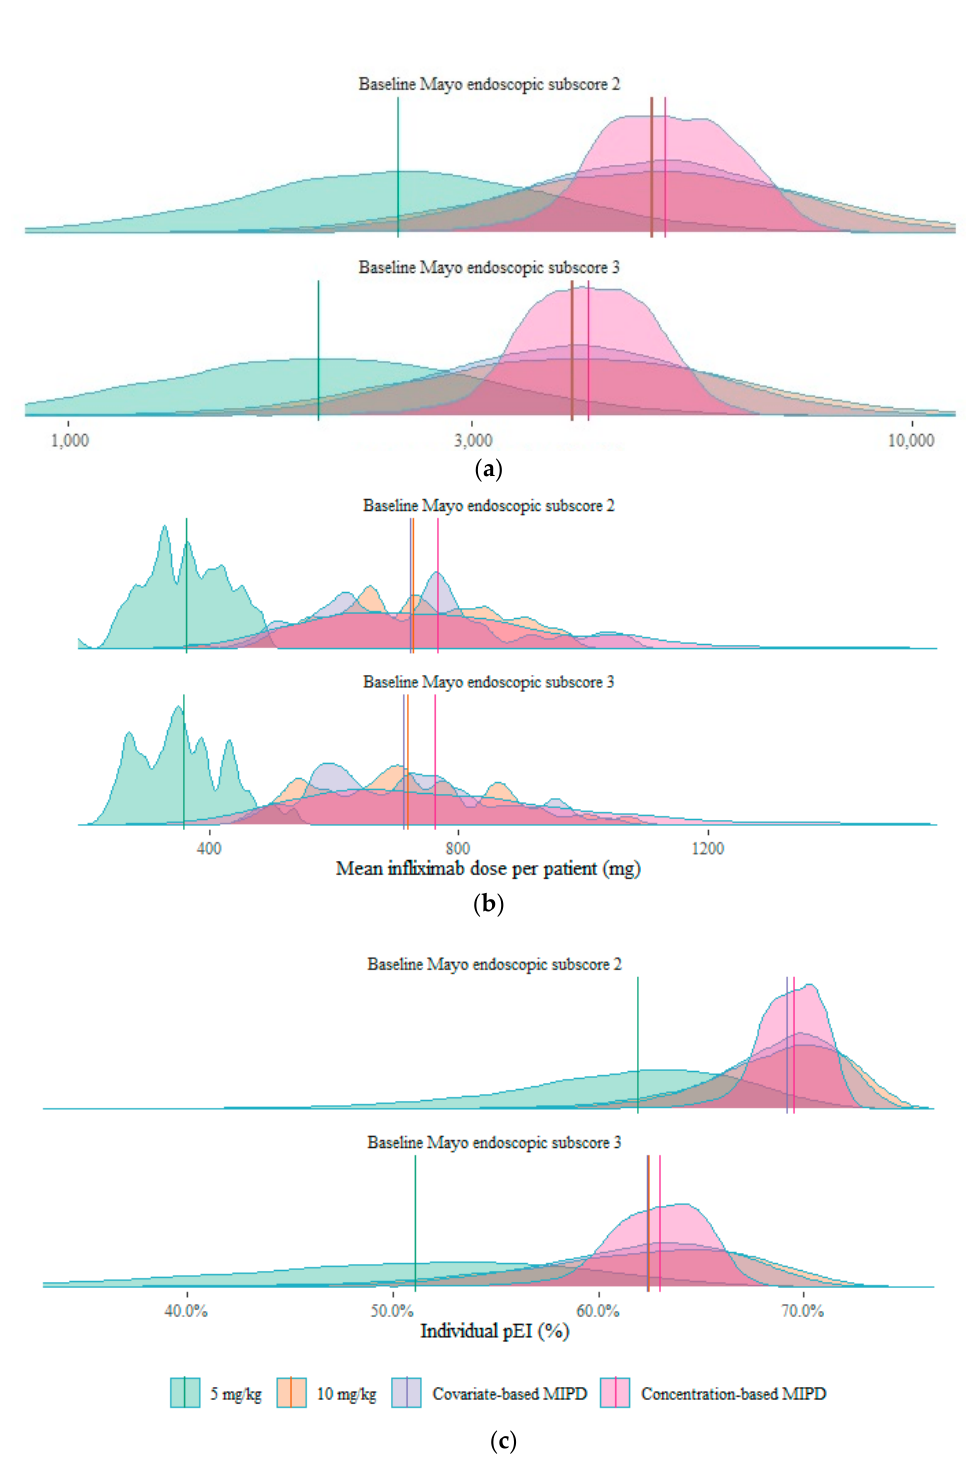
Figure 3. Predicted mean probability of endoscopic improvement versus median exposure, with 90% prediction interval in each scenario, per baseline Mayo endoscopic subscore. Black lines show model-predicted response. CAUC, cumulative area under the curve; MIPD, model-informed preci- sion dosing. Table 1. Summary of the simulation results.